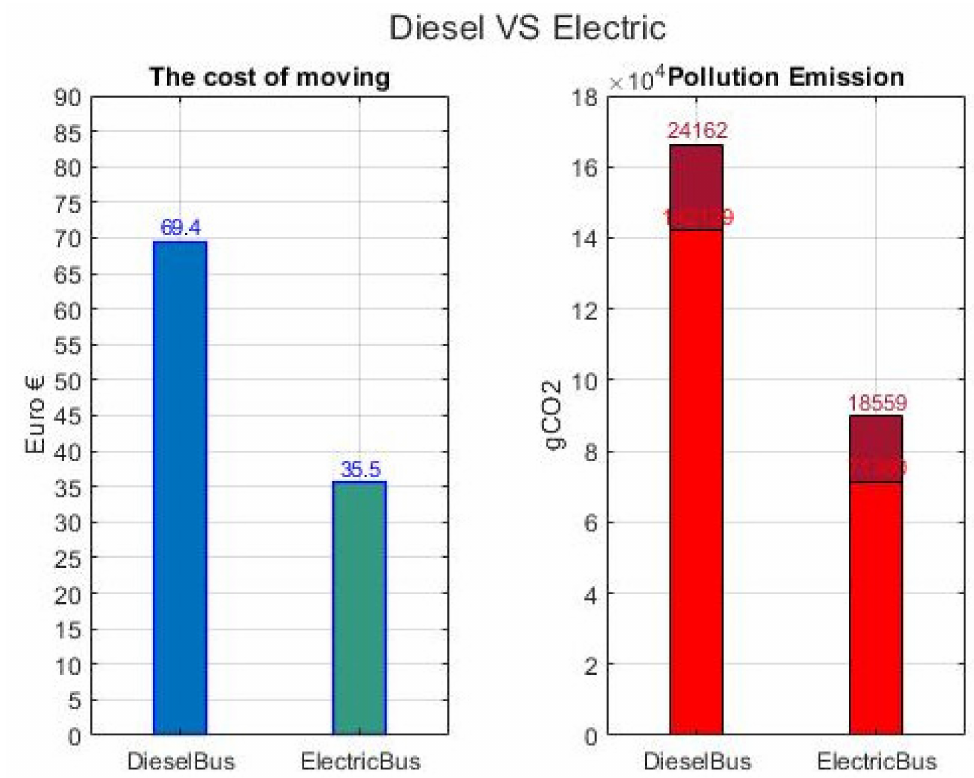
Figure 20. Diesel vs. electric bus, fuel cost, and pollution